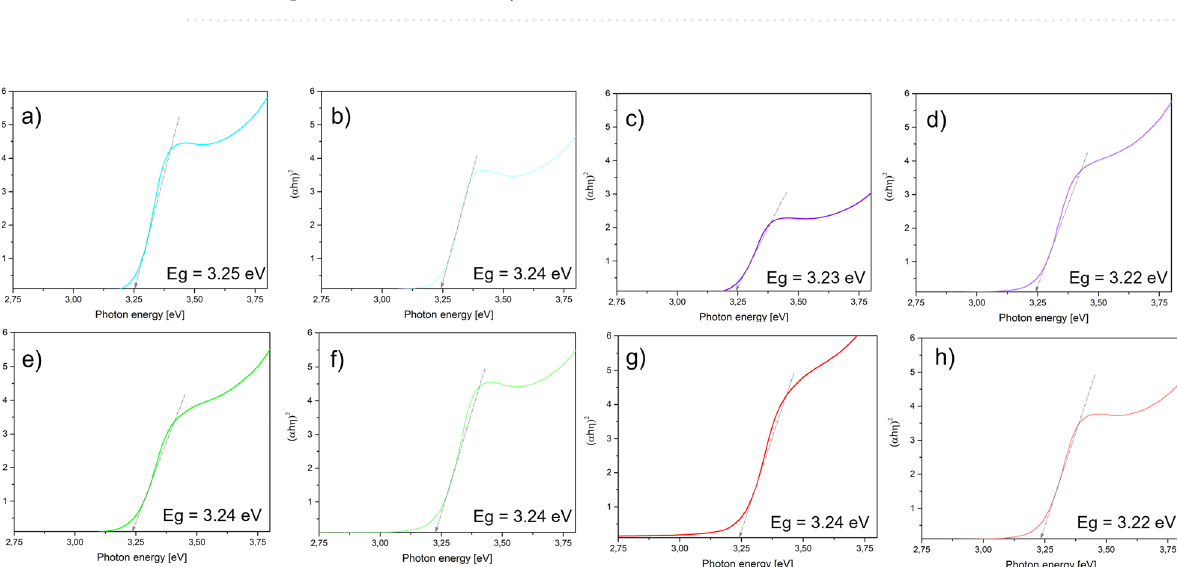
Table 2. Optical transmittance of hybrid thin films (for λ = 550 nm).